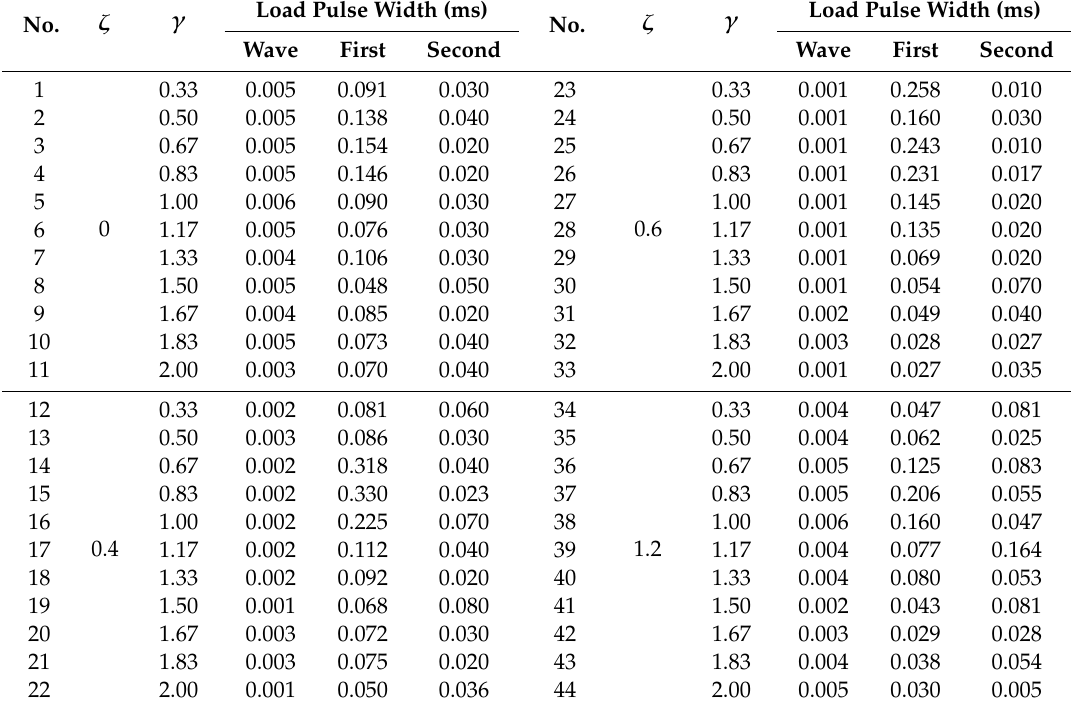
Table A2. Load pulse widths under di ff erent ζ and γ values.